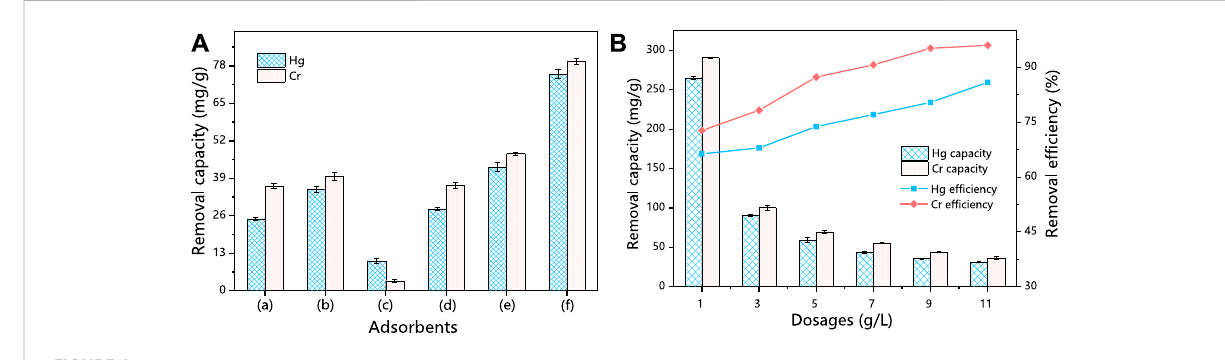
FIGURE 1 (A) Hg(II)andCr(VI)removalindifferentsystems. (B) In fl uenceofdifferentdosagesforthecapacitiesandef fi ciency.Conditions:C0=400